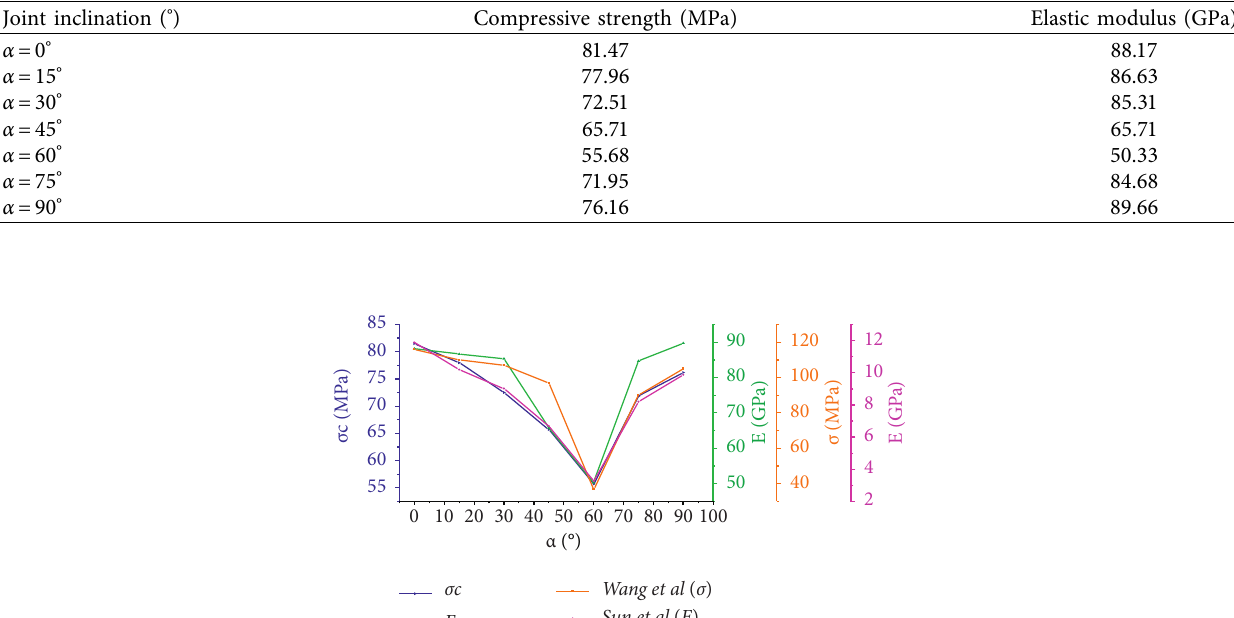
Table 3: Simulation results of sandstone compressive strength and elastic modulus.